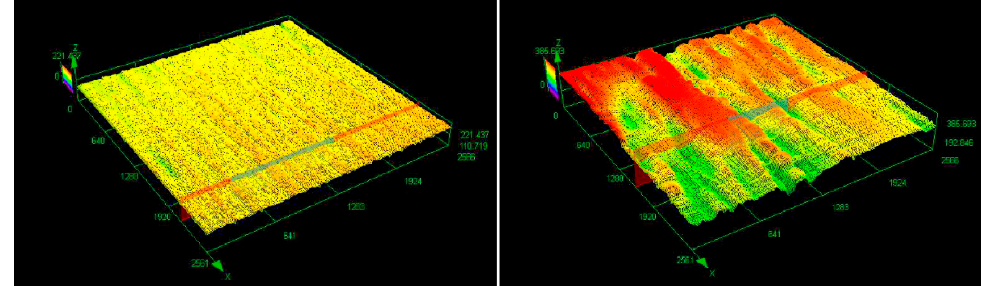
Figure 6. 3D image of maple wood surface before ( left ) and after 2 years of weathering ( right )—confocal laser scanning microscopy (area of 800 × 800 μ m).